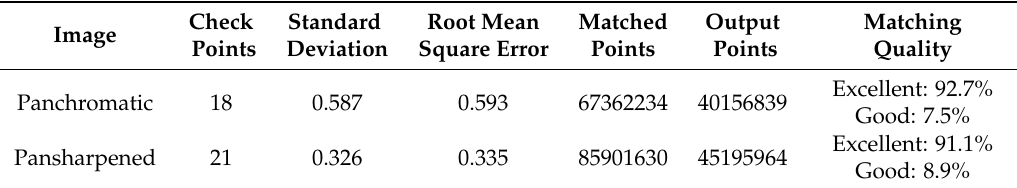
Table 3. Synthesis of the orientation residual after the